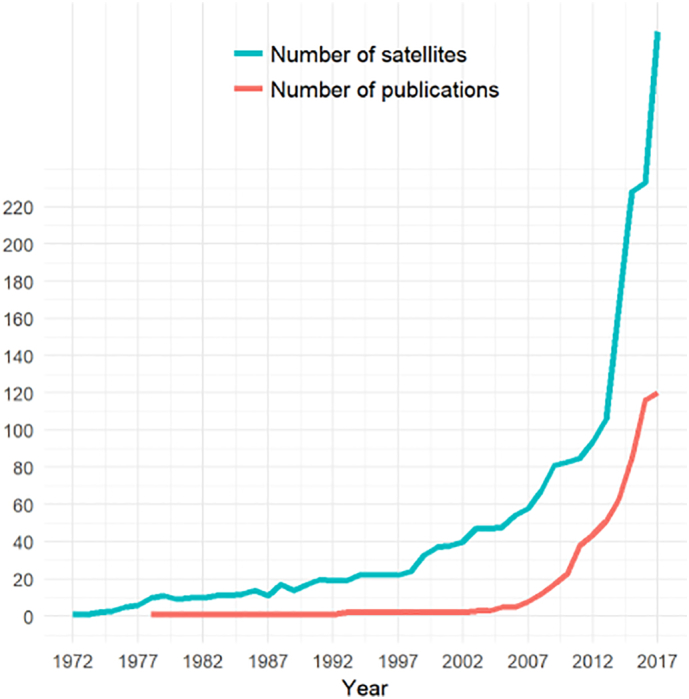
The number of publications on vessel detection (lower curve) has been rising following the increase of available optical satellites in orbit (upper curve). The number of publications inserted to represents all of the published papers on vessel detection in English which have been found and analysed by the authors of this research. The year 1972 marks the launch of the first civil optical satellite Landsat 1. The data on satellite launches are adapted and updated from Belward and Skøien (2015).